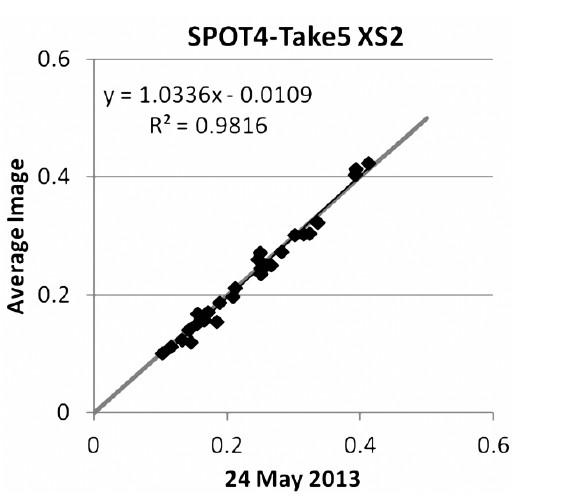
Figure 3. Comparison between the SPOT5 images after atmospheric correction using SMAC6S and the average SPOT5 reflectance for the 28 invariant sites, for spectral bands XS2 and XS3. Example of ( a ) an image for which no additional correction is required and ( b ) an image needing an additional correction.